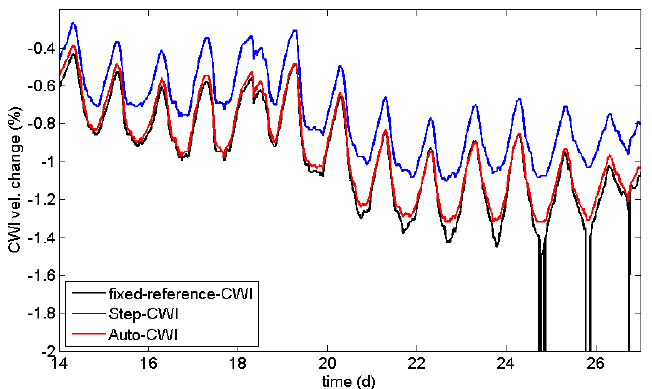
Figure 7. Detail of data shown in Figure 6. The general trend is similar for all procedures, but Step-CWI (blue line) shows a significant offset due to rounding errors and standard CWI (black line) is prone to fail at some